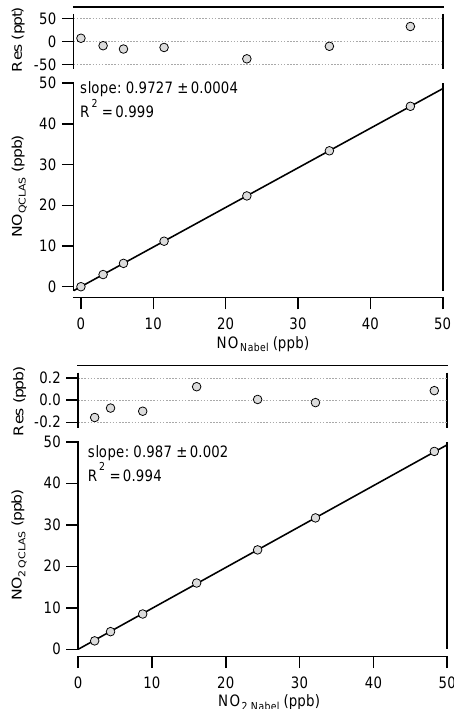
Fig. 4. Calibration plots of the QCLAS data for NO and NO 2 . The abscissa represents the values determined from standard gas dilu- tion (details in text). The fit (black line) is determined by weighted orthogonal distance regression and its residual shown in the upper part of each